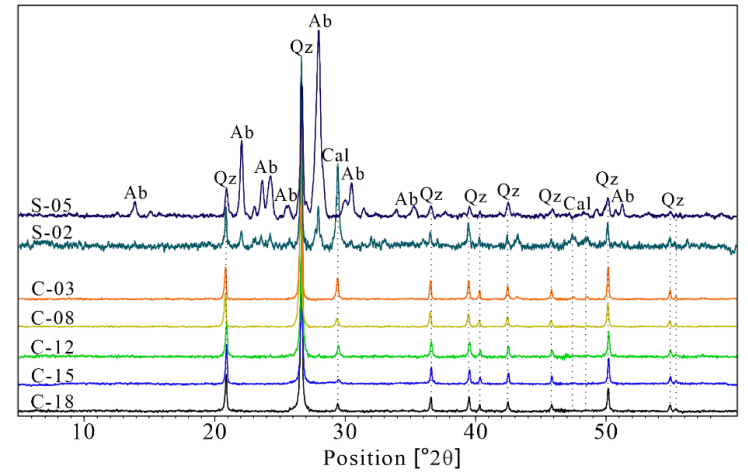
Figure 6. XRD patterns of chert nodules and surrounding rocks in the Lucaogou Formation, Junggar Basin. Qz = quartz; Cal = calcite; Ab = albite.